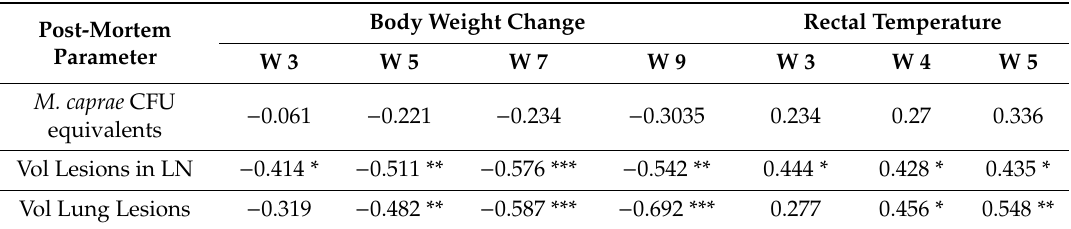
Table 1. Individual association between clinical and post-mortem